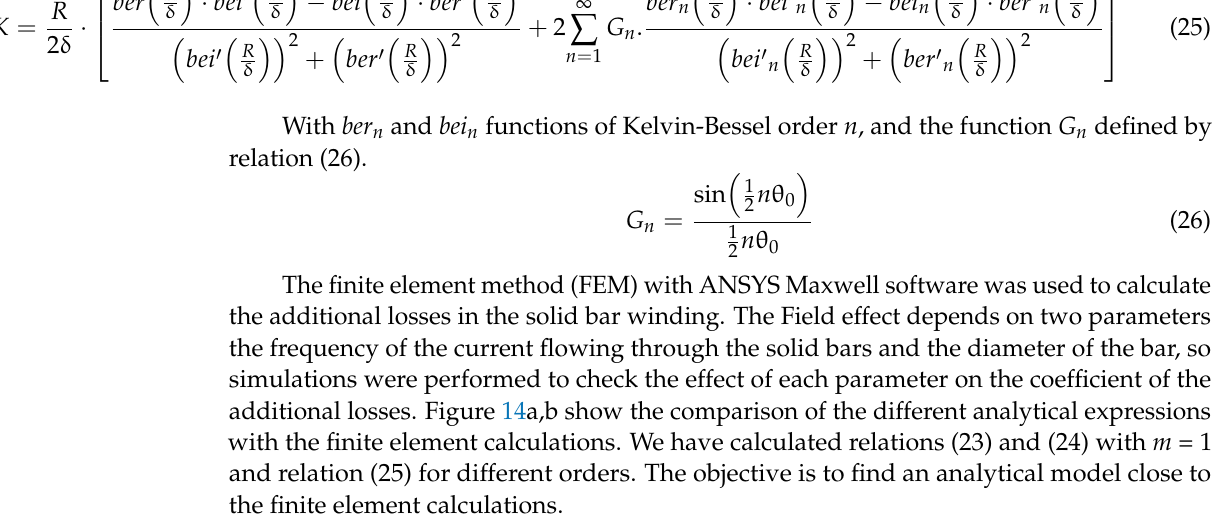
( b ) Figure 15. Winding detail with highlighting of the winding overhang: ( a ) Wire winding, ( b ) Solid- bar winding.